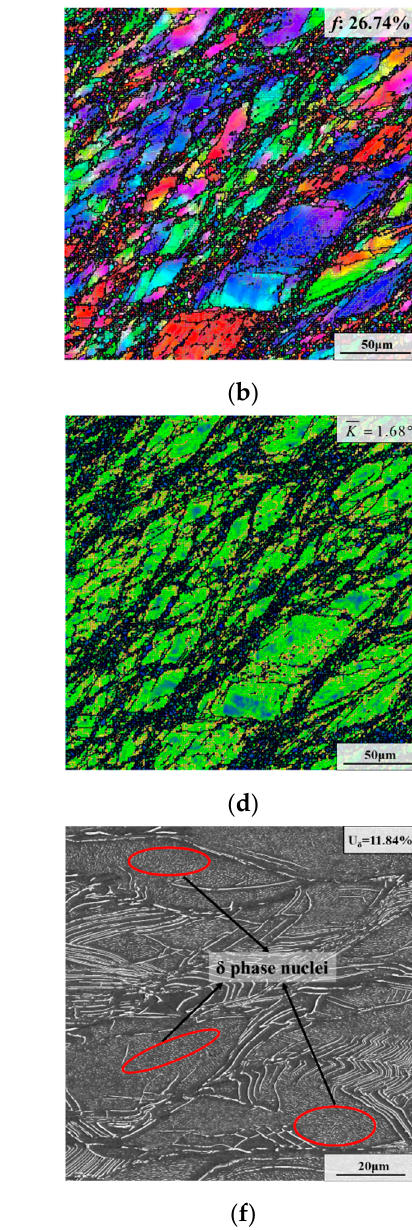
Figure 6. Deformed microstructures with different true strains: ( a , c , e ) 0.36; ( b , d , f ) 1.20. (The defor- mation temperature is 950 ◦ C, and the strain rate is 0.1 s − 1